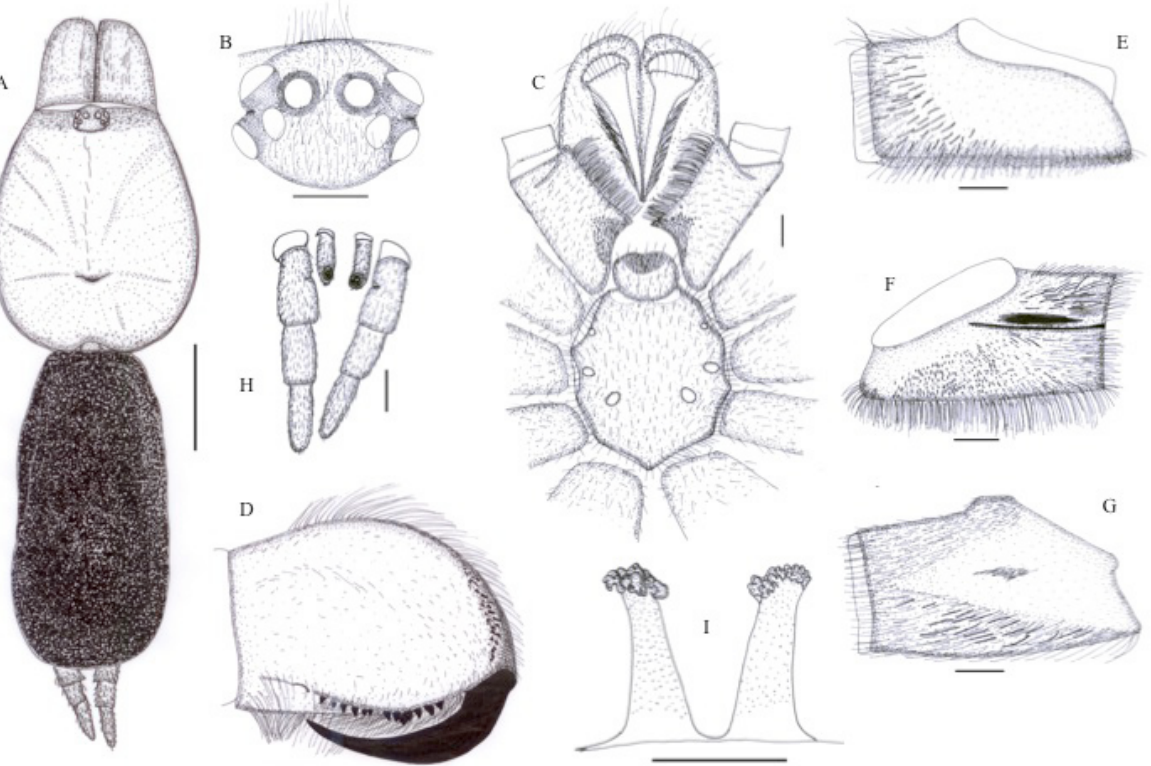
Figure 1. Neoheterophrictus crurofulvus sp. nov., female (WILD-10-ARA-1067). A - Carapace and abdomen dorsal view; B - Eye; C - Sternum, maxillae, labium, chelicerae; D - Chelicerae prolateral view; E - Maxillae, retrolateral view; F - Coxa I, prolateral view; G - Coxa I, retrolateral view; H - Spinnerets; I - Spermathecae. Scale 1.0mm for B-I and scale 0.5mm for